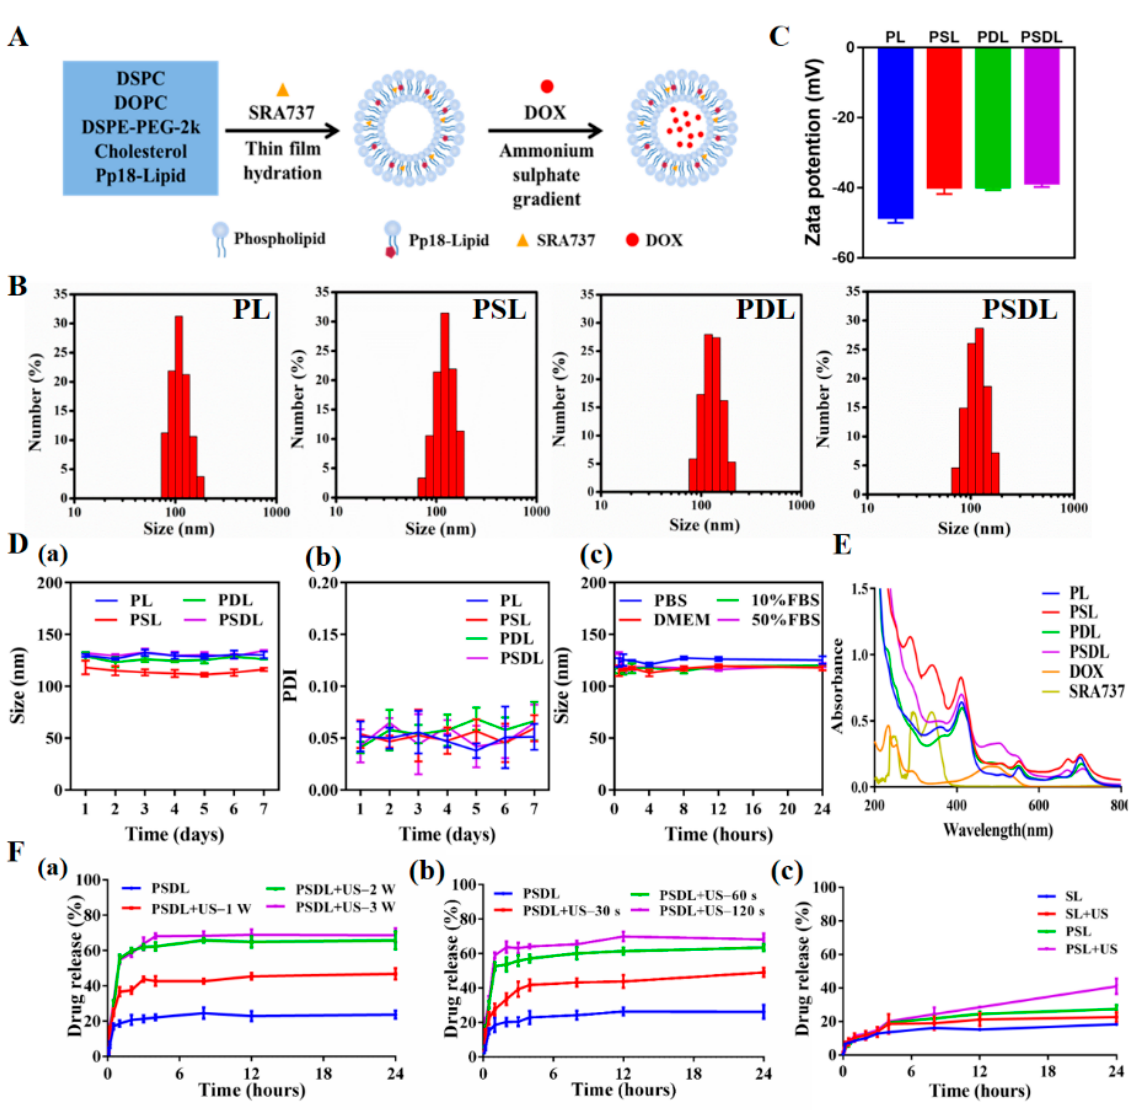
Figure 1. Synthesis and characterization of PSDL. ( A ) Schematic illustration diagram of the PSDL; ( B ) the particle size distribution of different liposomes; ( C ) zeta potentials of each group; ( D ) particle size stability of PL, PSL, PDL, and PSDL at 4 ◦ C ( a ); PDI of PL, PSL, PDL, and PSDL at 4 ◦ C ( b ); the particle size stability of PSDL in PBS, DMEM, 10% FBS, and 50% FBS at 37 ◦ C ( c ); ( E ) UV-Vis absorption spectrum of each group; ( F ) release profiles of DOX from PSDL with/without different ultrasonic intensity ( a ), ultrasonic time ( b ), and the release profiles of SRA737 ( c ) from PSL in the absence and presence of ultrasonic stimulation.